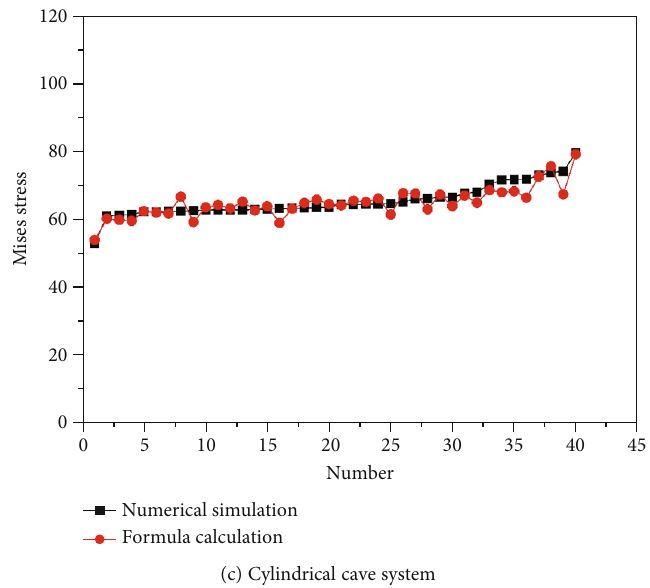
Figure 11: Numerical simulation curve and fi tting curve for cave